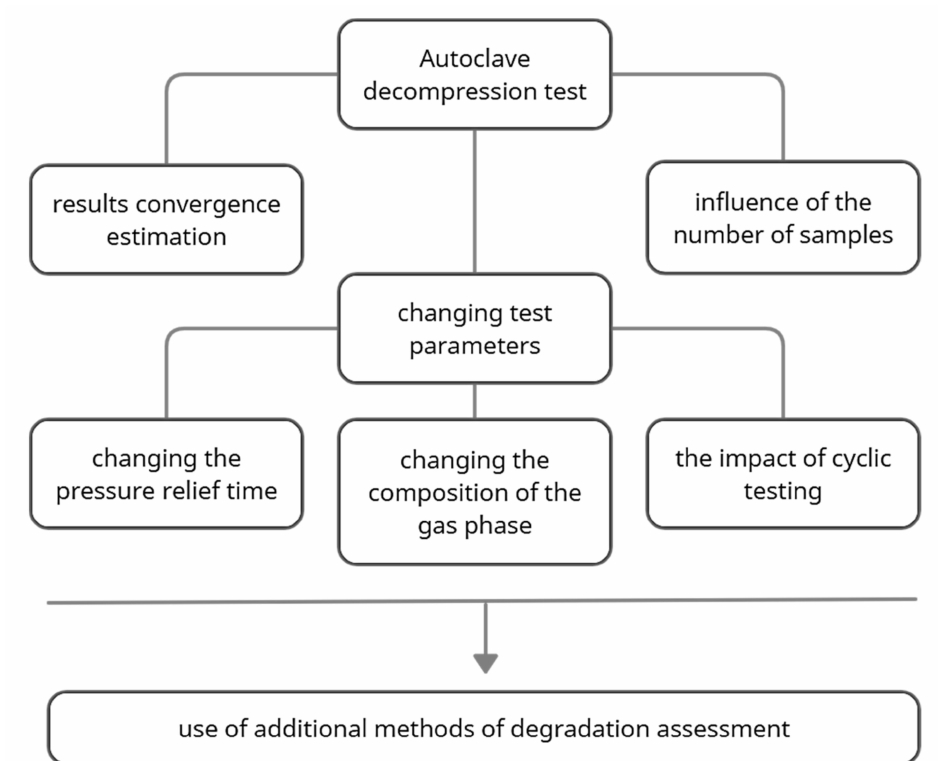
Figure 3. Research plan